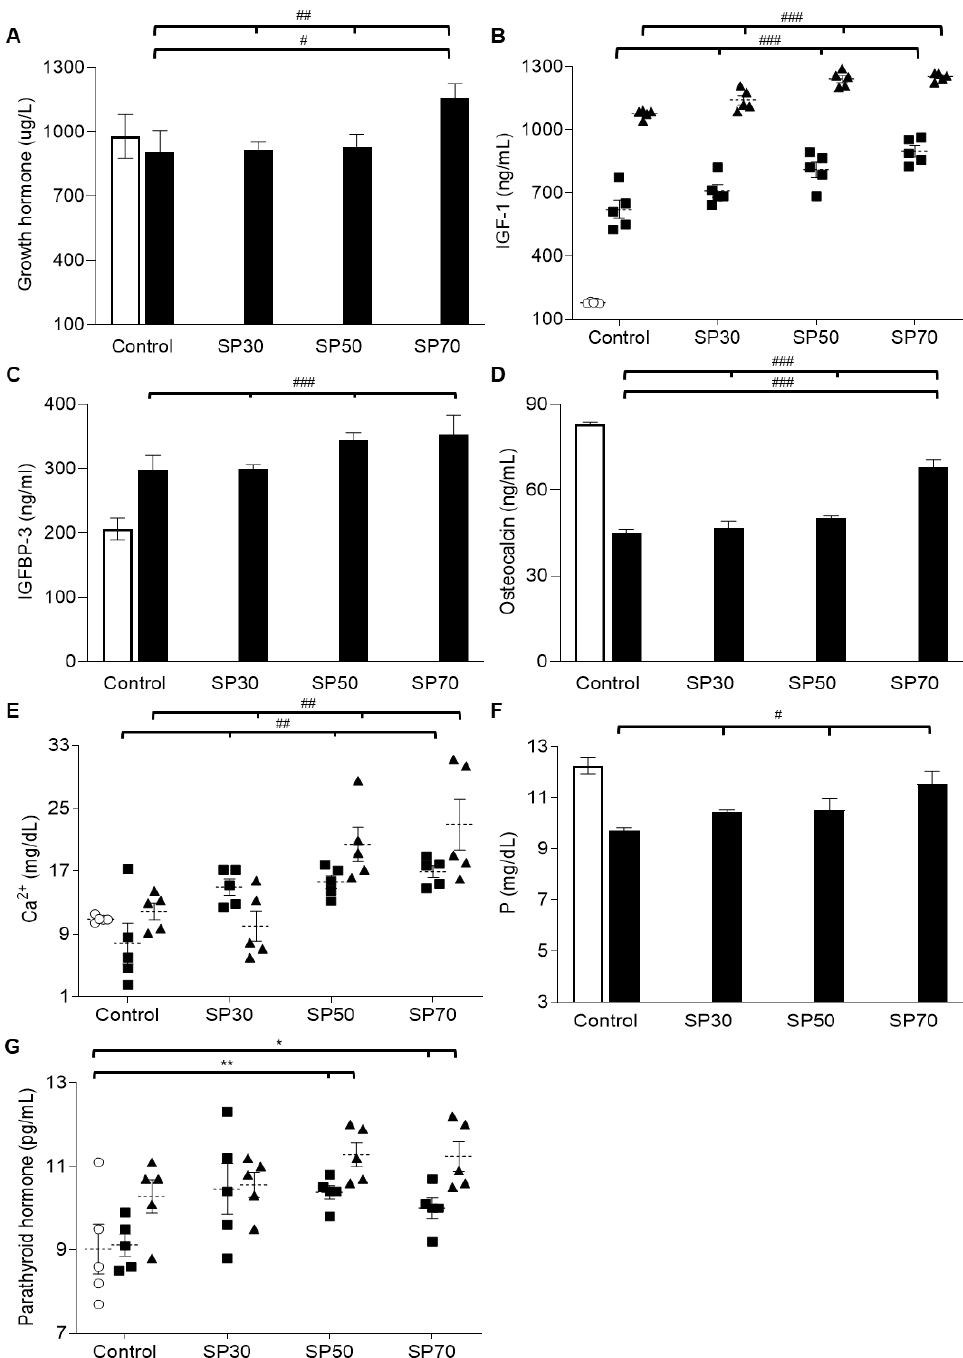
Figure 3. E ff ect of spirulina on growth hormones and related hormones in blood. Plasma ( A ) Growth hormone (GH), ( B ) insulin-like growth factor 1 (IGF-1), ( C ) insulin-like growth factor binding protein 3 (IGFBP-3), ( D ) osteocalcin, ( E ) free calcium, ( F ) free phosphate, and ( G ) parathyroid hormones (PTHs) were measured in growing male rats over the 7-week course of study. Data are mean ± SEM values. Significant di ff erences were determined using t -tests or one-way ANOVA with post hoc Duncan’s multiple-range test comparisons. * p < 0.05, ** p < 0.01 between weeks within a group and # p < 0.05, ## p < 0.01, or ### p < 0.001 between groups in the same week. Control: AIN 93G diet; SP30: 30% of protein source replaced with spirulina; SP50: 50% of protein source replaced with spirulina; SP70: 70% of protein source replaced with spirulina. The week of the treatment is represented by O: 0 weeks; (cid:4) : 3 weeks; (cid:78) : 7 weeks in each group. White bar: 0 weeks; black bar: 7